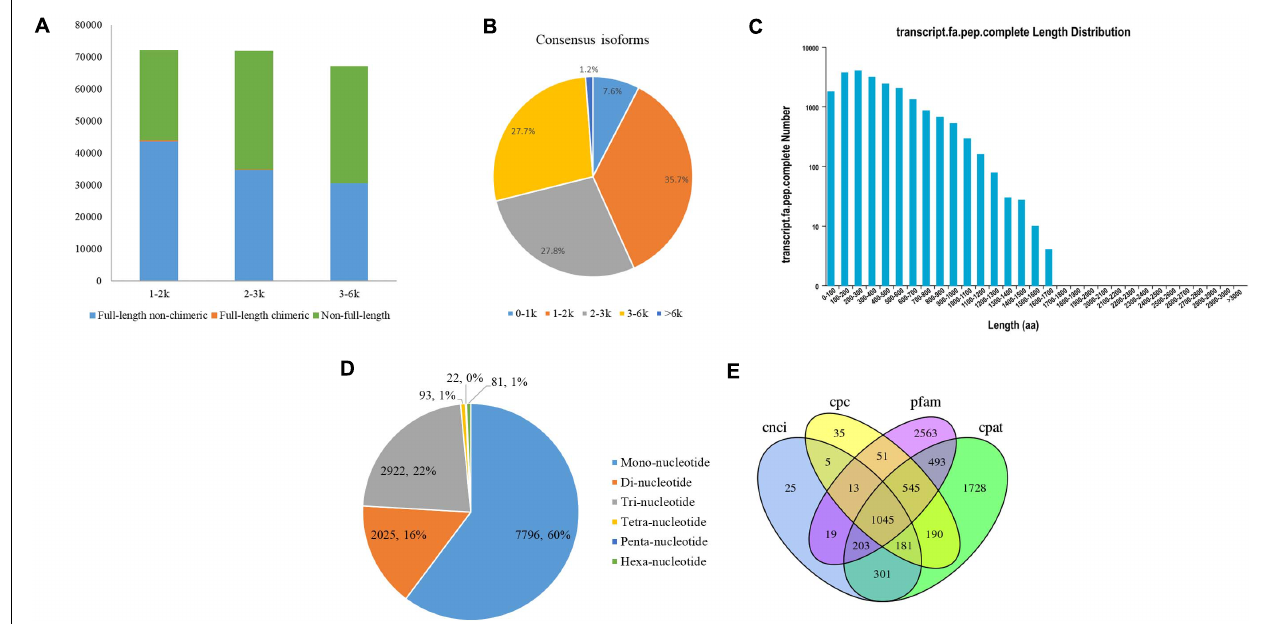
FIGURE 1 | PacBio Iso-Seq Full-length transcriptome analysis. (A) Distributions of full length non-chimera (FLNC), full length chimera and non-full length transcripts in faba bean bud libraries. (B) Length distributions of consensus isoforms. (C) Length distribution of CDS. (D) Type distribution of SSRs. (E) Venn diagram showed the number of lncRNA identified by four